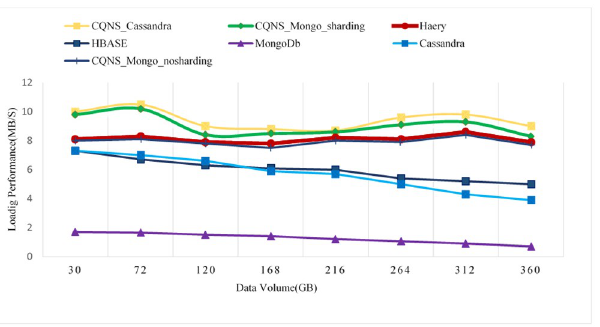
Fig 22. Comparison of loading speed among six data